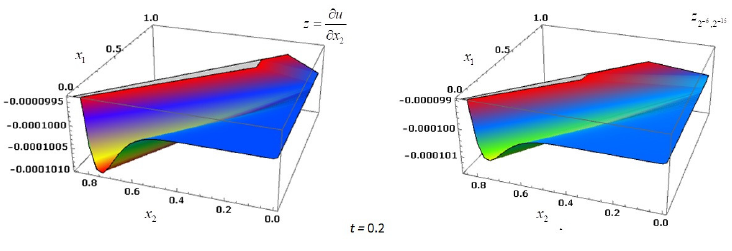
Figure 6. The exact solution z = ∂ u